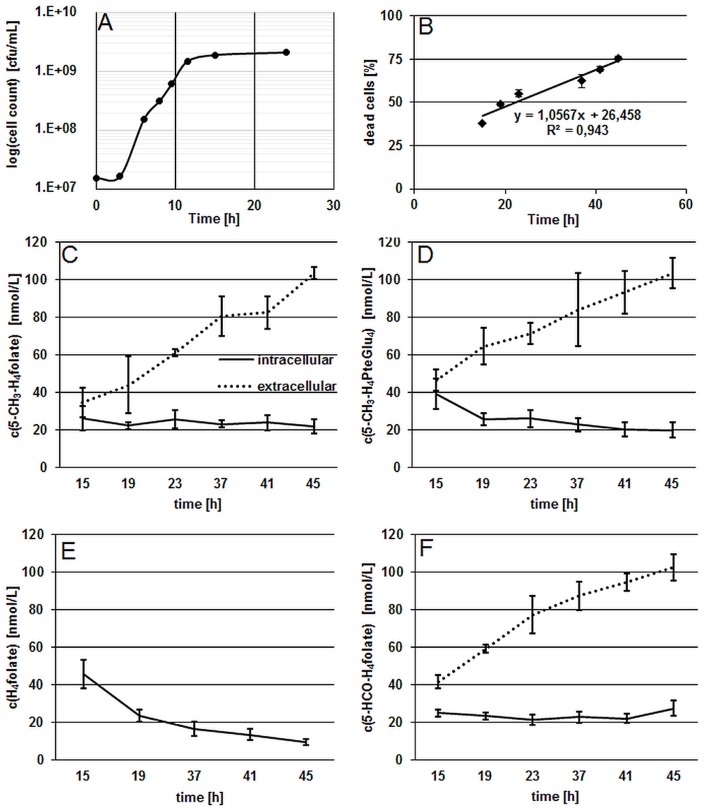
Characterization of growth and folate production in B. adolescentis DSM 20083T during the stationary phase. (A) Growth curve of B. adolescentis DSM 20083T in FFM determined by the drop plate method (cells counted two times), measurement uncertainty 6.1%. (B) Linear increase of dead cells during the stationary phase. (C,D) Intra- and extra-cellular folate concentrations of 5-CH3-H4folate (C) and 5-CH3-H4PteGlu4
(D) depicted as means of triplicate extraction. (E) Intra-cellular concentrations of H4folate. (F) Intra- and extra-cellular concentrations of 5-HCO-H4folate.